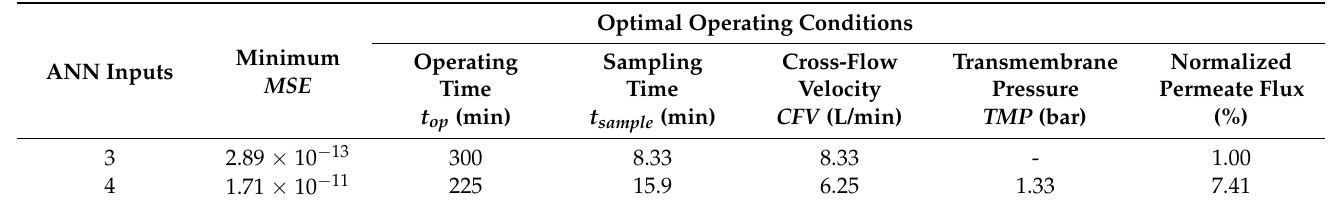
Table 6. Optimal performance and operating conditions for both ANNs